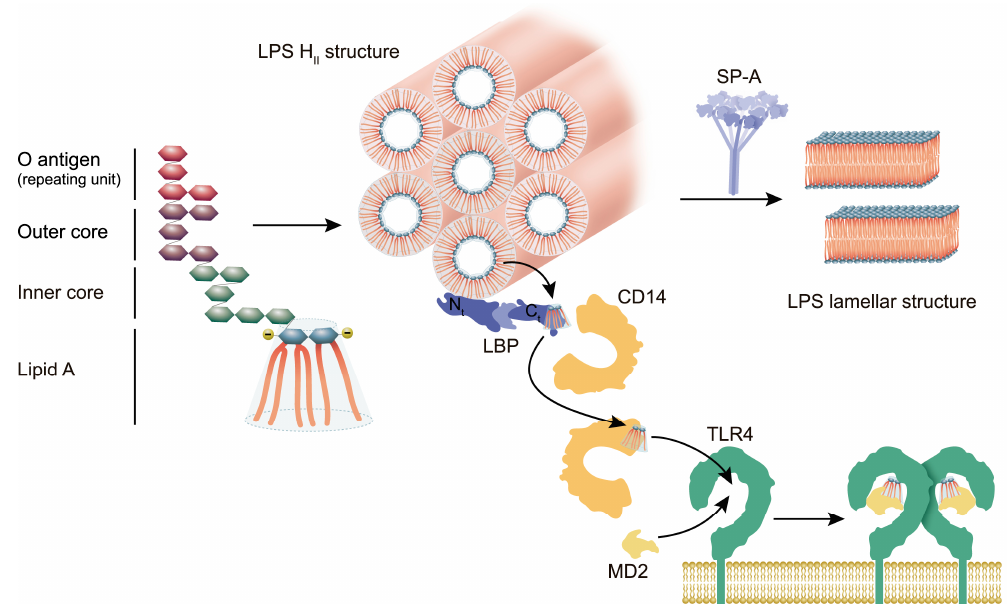
Figure 3. Host response to lipopolysaccharide (LPS). LPS is composed of lipid A, the hydrophobic membrane-anchoring region, and a hydrophilic part formed by the core oligosaccharide region and the O-antigen. The core oligosaccharide region includes an outer core region, enriched in hexoses, and an inner core region proximal to lipid A that contains 3-deoxy-D- manno -octulosonic acid [184] . The O-antigen, also termed O-specific chain, contains up to 50 highly variable oligosaccharide units. Both the acyl chains and the negative charges of the phosphate groups bound to the diglucosamine backbone of lipid A are required for the recognition of LPS by cell receptors and the subsequent activation of the host immune system. LPS molecules associate forming non-lamellar supramolecular structures that are recognized by LBP, which transfers LPS monomers to CD14. LPS is subsequently transferred to the TLR4 / MD2 complex, triggering complex dimerization and initiating the signaling cascade. Interaction of surfactant protein SP-A (functional form, octadecamer) with LPS modifies the aggregated LPS structure, inducing formation of lamellar phases, and therefore preventing the recognition of LPS by LBP.